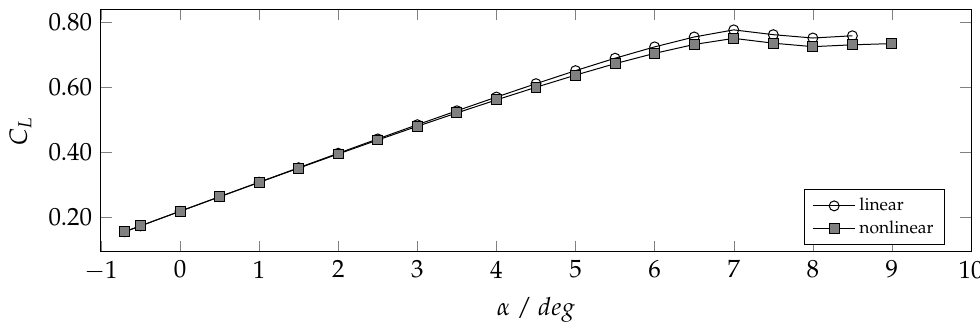
Figure 4. Lift coefficient with respect to the angle of attack